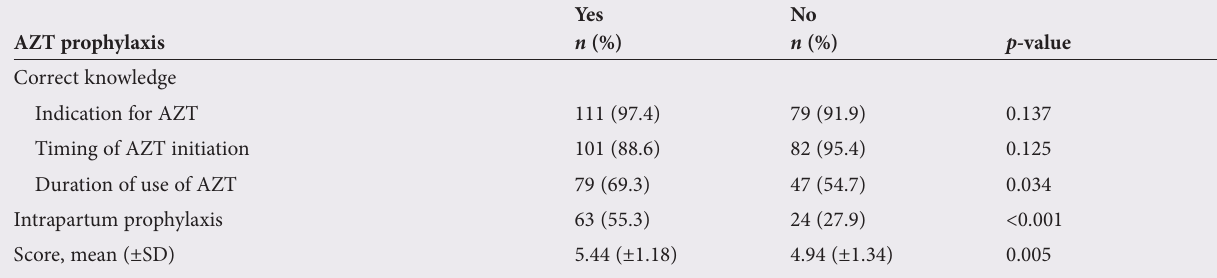
Table 3. Difference in knowledge in pregnant women who were already on zidovudine (AZT) prophylaxis ( N =114) and those who were not ( N =86) AZT